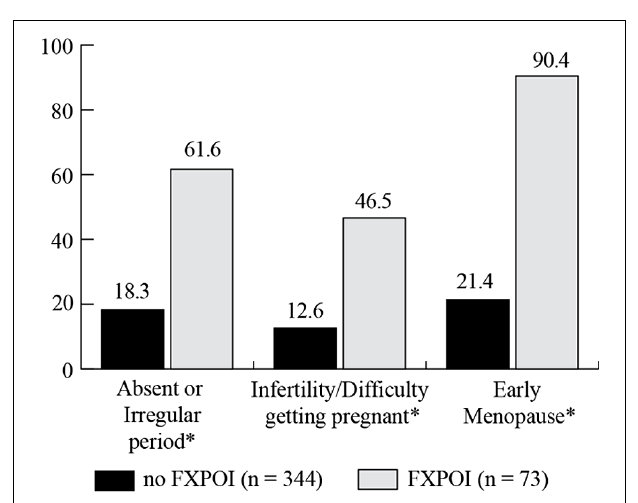
FIGURE 7 | Percentage of women with and without FXPOI experiencing reproductive challenges. *Significant differences between groups.